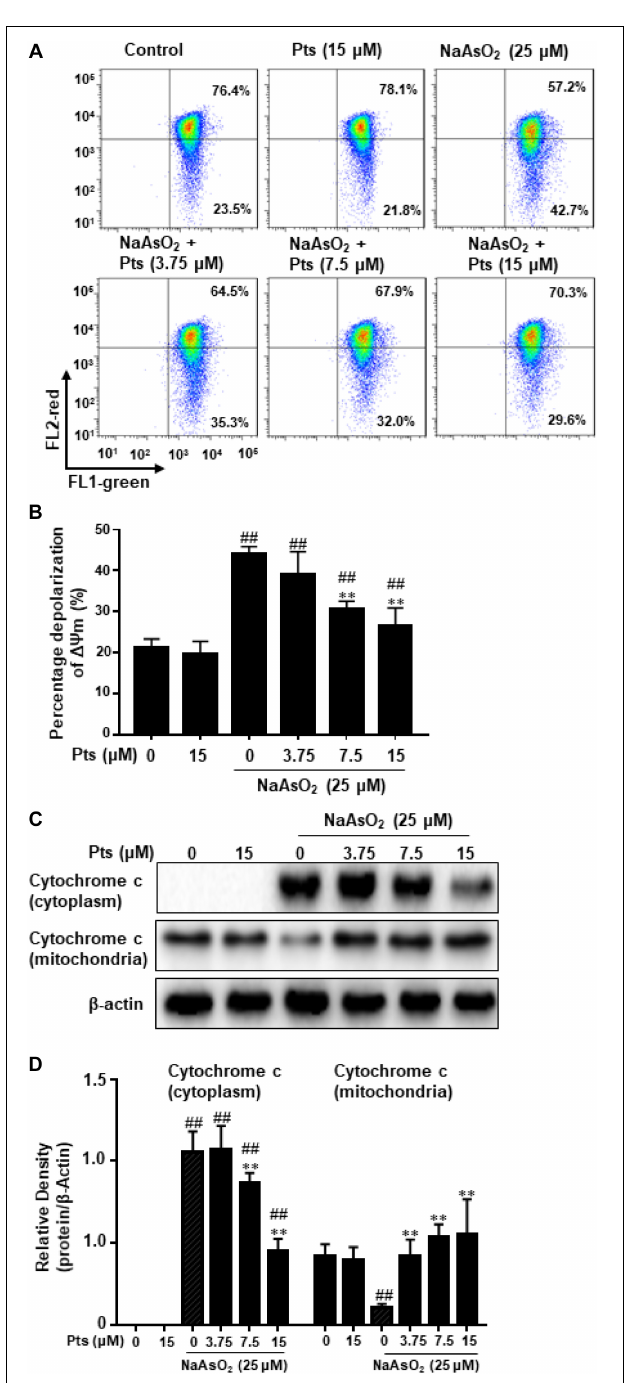
FIGURE 3 | Protective effect of Pts pretreatment against NaAsO 2 -induced mitochondrial dysfunction in HaCaT cells. The HaCaT cells were exposed to 25 µ M of NaAsO 2 for 24 h with or without Pts (3.75, 7.5, and 15 µ M) pretreatment. (A) Mitochondrial membrane potentials ( (cid:49)(cid:57) m) were assessed with JC-1 staining by flow cytometry, and the percentage of cells with depolarization of (cid:49)(cid:57) m were quantified in panel (B) . (C) Cytochrome c levels in the mitochondria and cytoplasm were detected by western blot analysis, and the band densities were quantified in panel (D) . The results are expressed as the means ± S.E.M. of three independent experiments. ## P ≤ 0.01 versus the control group, ∗∗ P ≤ 0.01 versus the NaAsO 2 group.